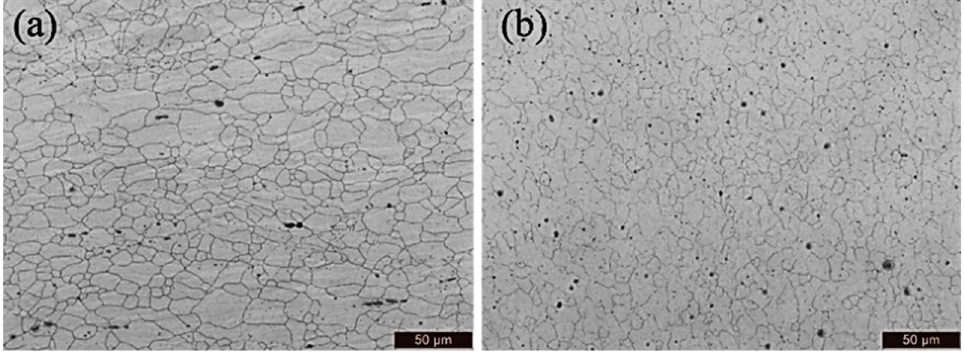
Figure 3. OM image of the FSW weld: ( a ) base materials; ( b ) SZ.